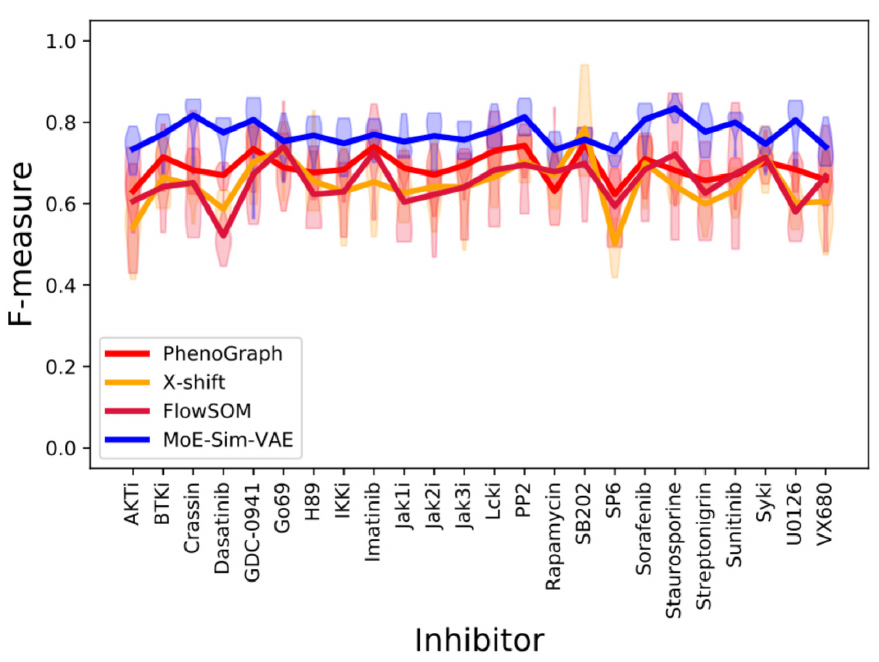
Fig 4. Results on clustering cell types on CyTOF measurements. Comparison of MoE-Sim-VAE to the most popular competitor methods on defining cell types in peripheral blood mononuclear cell data via CyTOF measurements. On the x-axis different inhibitor treatments are listed whereas the y-axis reports the respective F-measure. Each violin plot represents a run on a different inhibitor with multiple wells, whereas the line connects the means of the performance on the specific